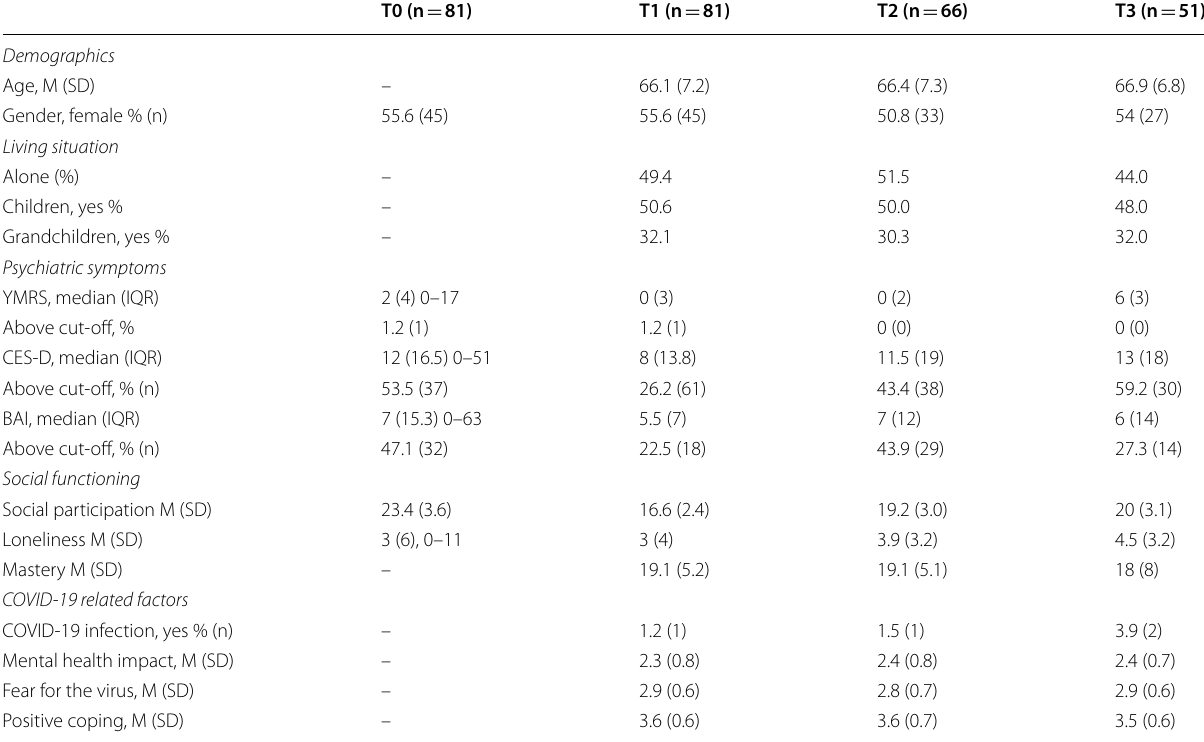
T1 April 2020, T2 June 2020, T3 September 2020 = = = YMRS, Young Mania Rating Scale; CES-D, Center for Epidemiologic Studies Depression Scale; BAI, Beck Anxiety Inventory; IQR, interquartile range; M, mean; SD, standard